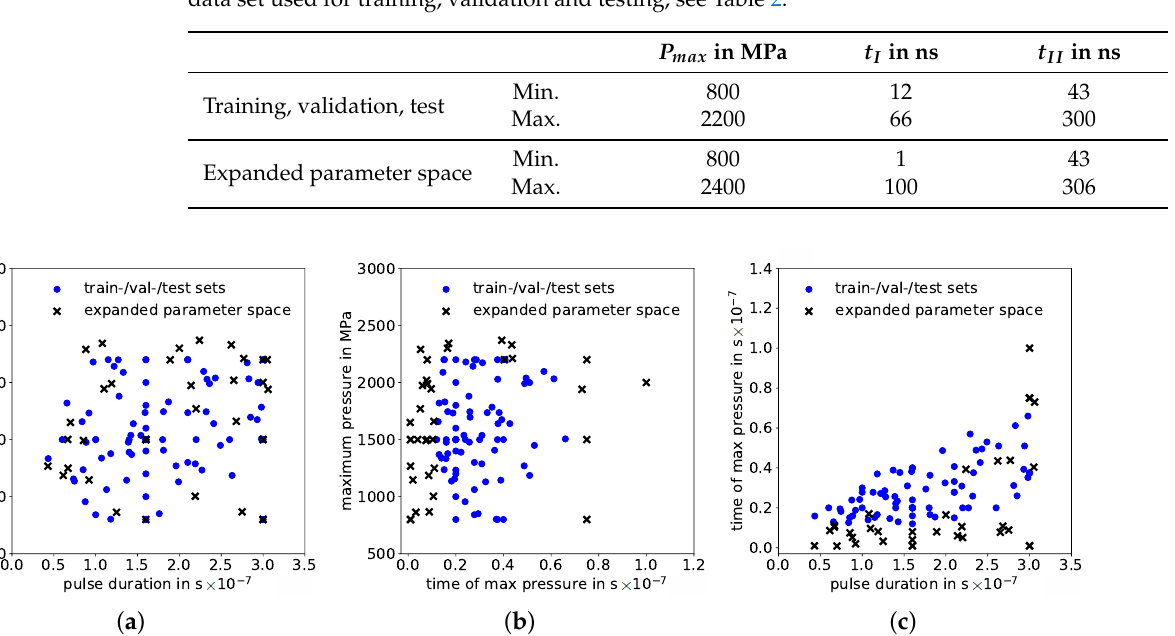
Figure 11. Sample positioning in the expanded parameter space: Maximum pressure over ( a ) pulse duration and over ( b ) time of maximum pressure as well as ( c ) time of maximum pressure over pulse